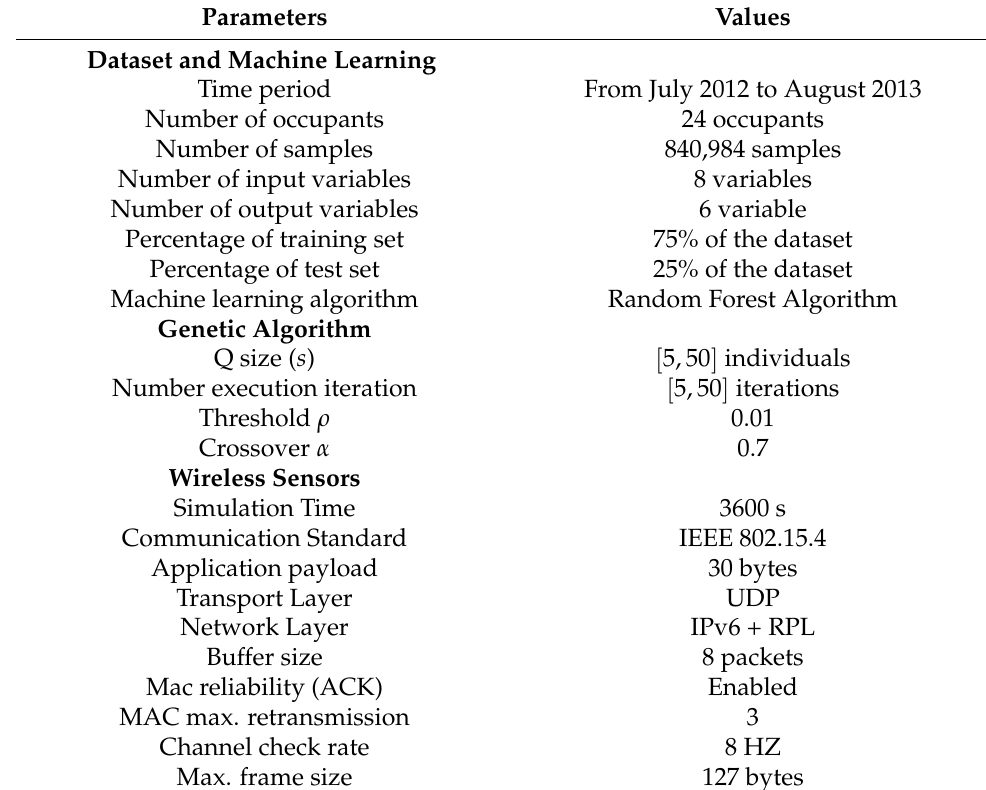
Table 4. Implementation